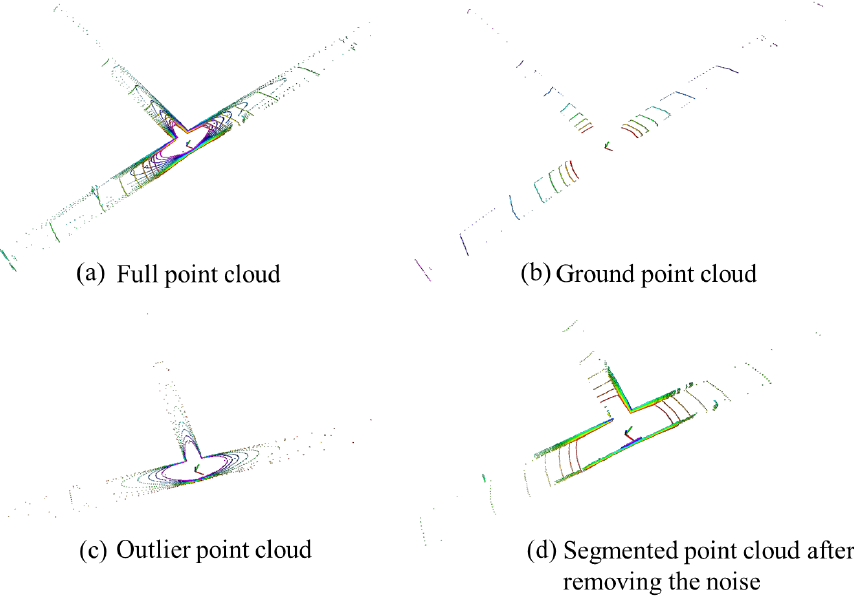
Figure 20. Point cloud segmentation results.